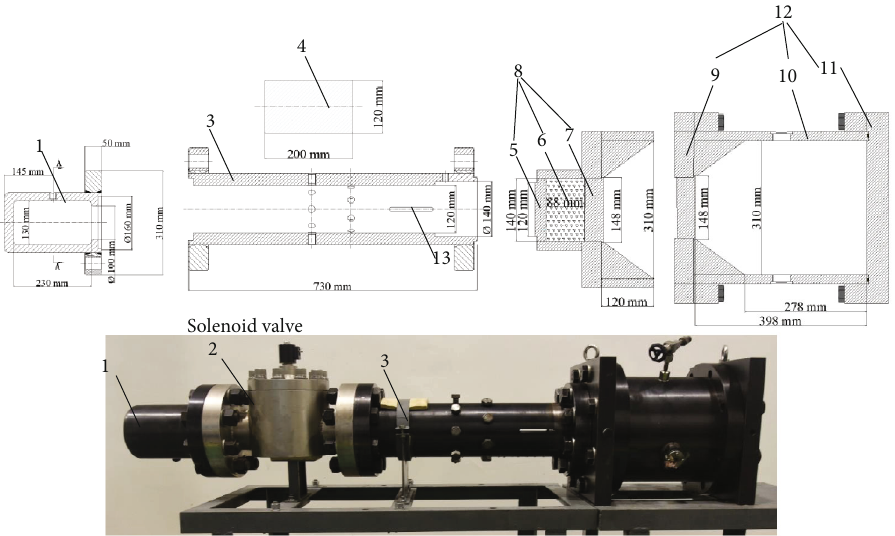
Figure 3: Schematic of the experimental device and its main components. 1-High-pressure gas chamber; 2-solenoid valve; 3-launch tube; 4- steel projectile; 5-PTEF plate; 6-the medium for wave adjustment; 7-pressure plate; 8-composite pulse shaper; 9- fl ange plate; 10-container tube; 11-bottom cap; 12-container; 13-observation hole of velocity of the steel projectile.